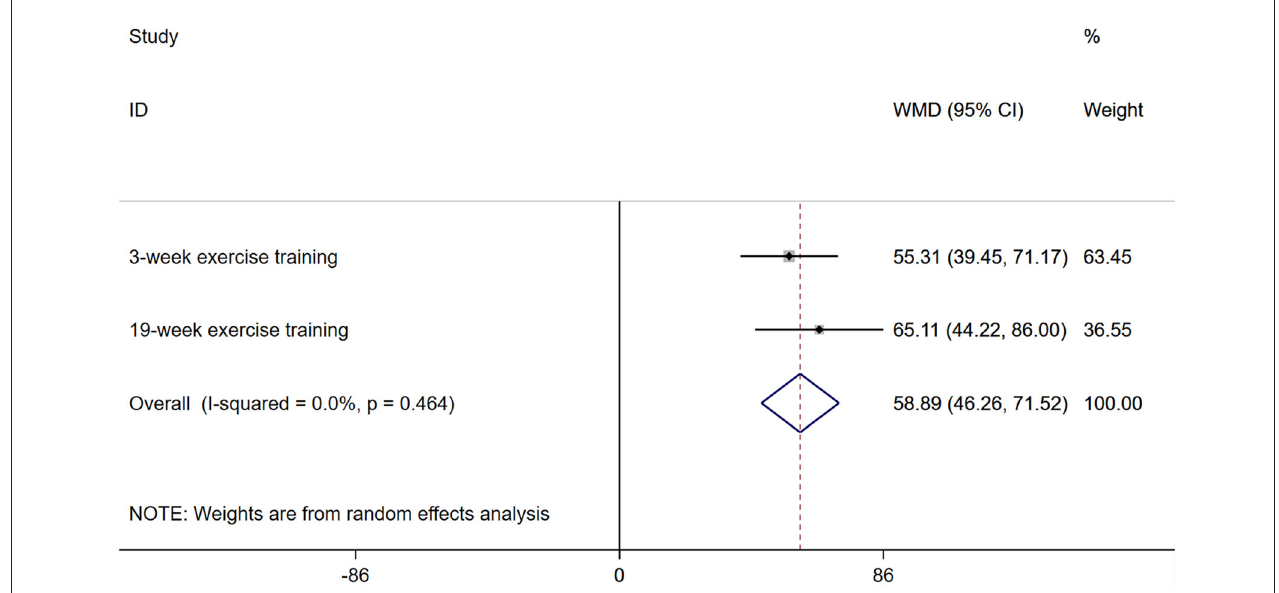
FIGURE 2 | Forest plots for the 6-min walking distance. 6MWD, six-minute walking distance.